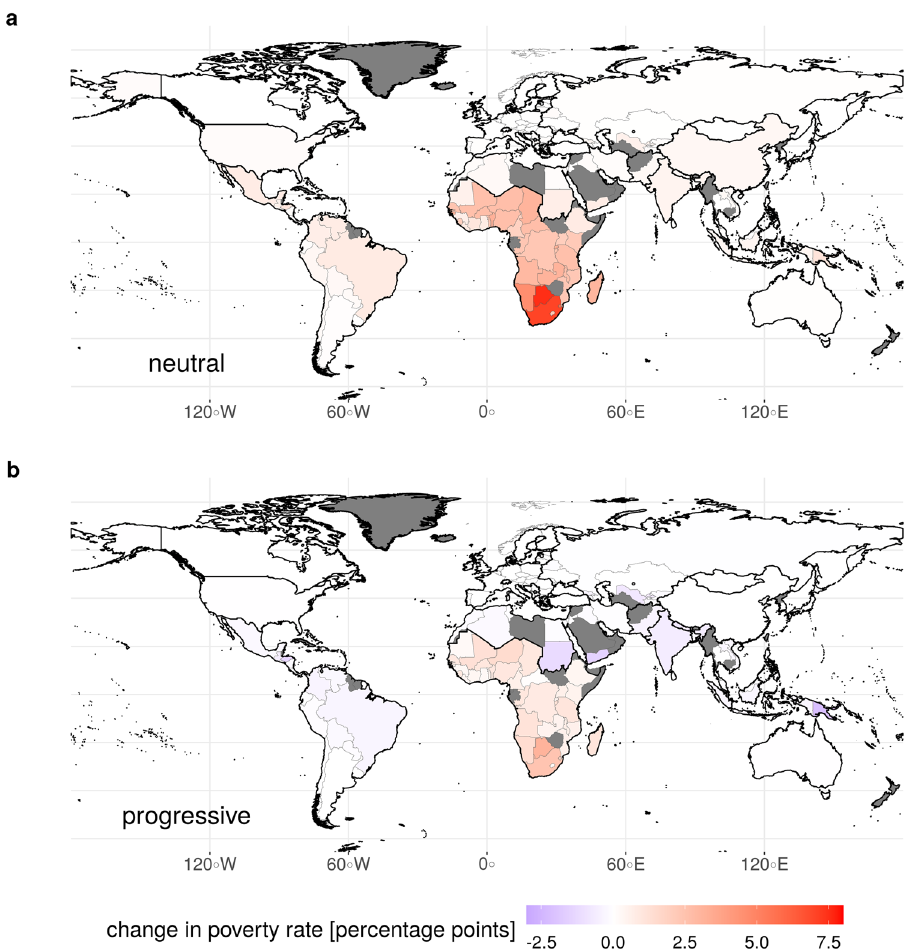
Fig. 2 Effect of ambitious mitigation policies on poverty rates in 2030 (SSP2). We show here our projections for the difference between policy and baseline poverty rates for the two different revenue recycling schemes. While climate policy without associated progressive redistribution (panel a , ‘ neutral ’ ) would lead to a substantial increase in poverty rates, this policy side effect could be reduced or largely overcome by redistributing the associated carbon pricing revenue (panel b , ‘ progressive ’ ). Light grey lines show national borders, while solid black lines delineate the model regions used in